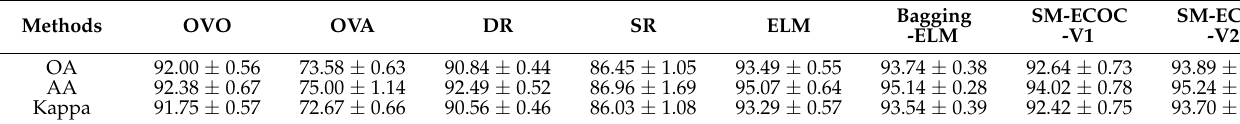
Table 7. Accuracy (%) of different classification models established based on feature bands.